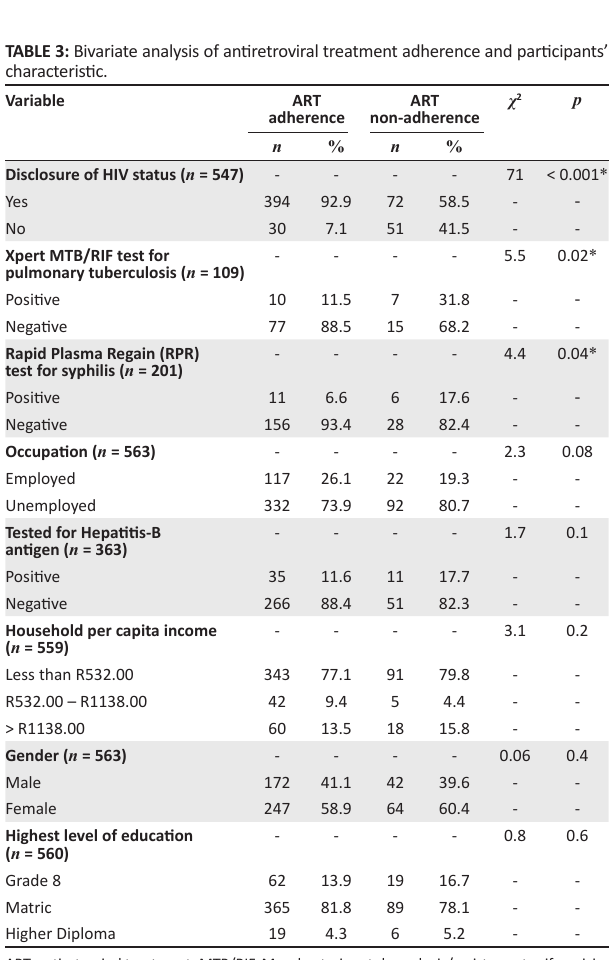
FIGURE 3: Distribution of average adherence among substance users and non- substance users.